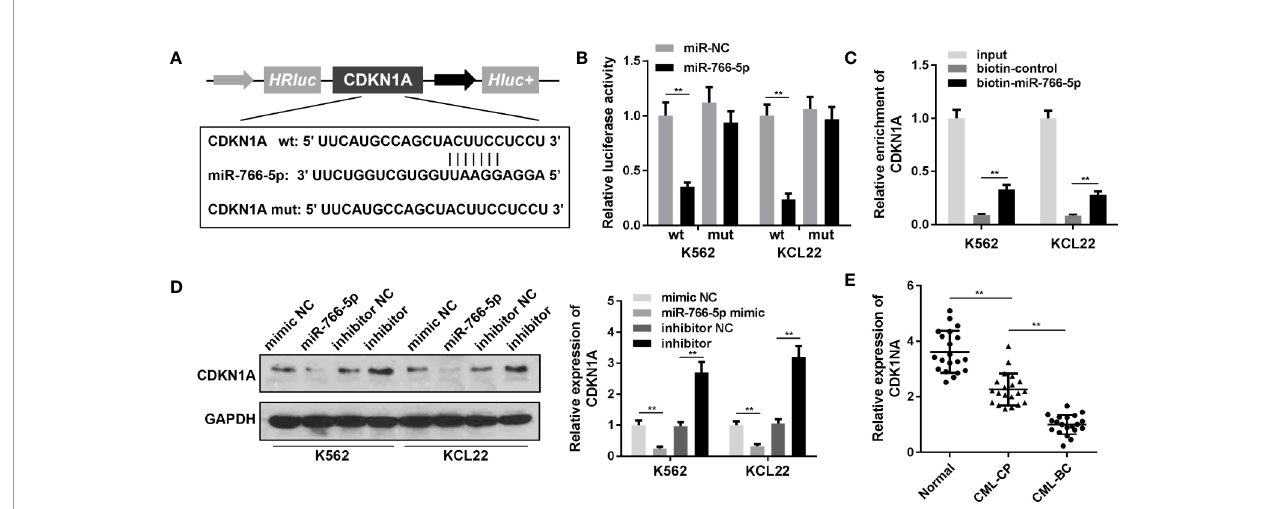
FIGURE 5 | CDKN1A is a target of miR-766-5p. (A) The binding sites between miR-766-5p and CDKN1A. (B) The luciferase activities of CML cells. (C) The interaction between CDKN1A and miR-766-5p. (D) The protein expression of CDKN1A protein in CML cells. (E) The expression of CDKN1A in CML cells. **P < 0.01 vs. miR-NC, si-NC, vector, biotin-NC or normal. CML, chronic myeloid leukemia; NEAT1, lncRNA nuclear enriched abundant transcript 1; CP, chronic phase; BC, blast crisis; NC, negative